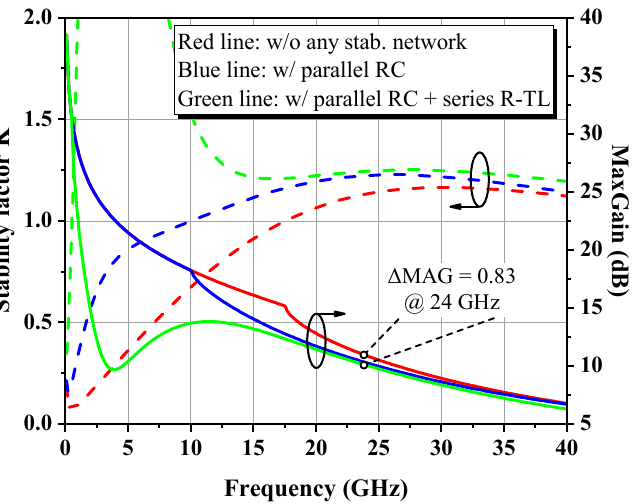
Figure 4. Simulated K-factor and MAG of the 46 × 8 μ m GaN transistor, with and without stabiliza- tion networks.